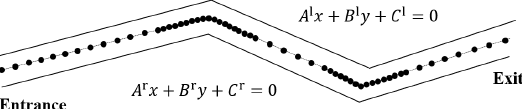
Figure 4. Centerline discretization. The upper formula represents the left boundary while the lower formula represents the right